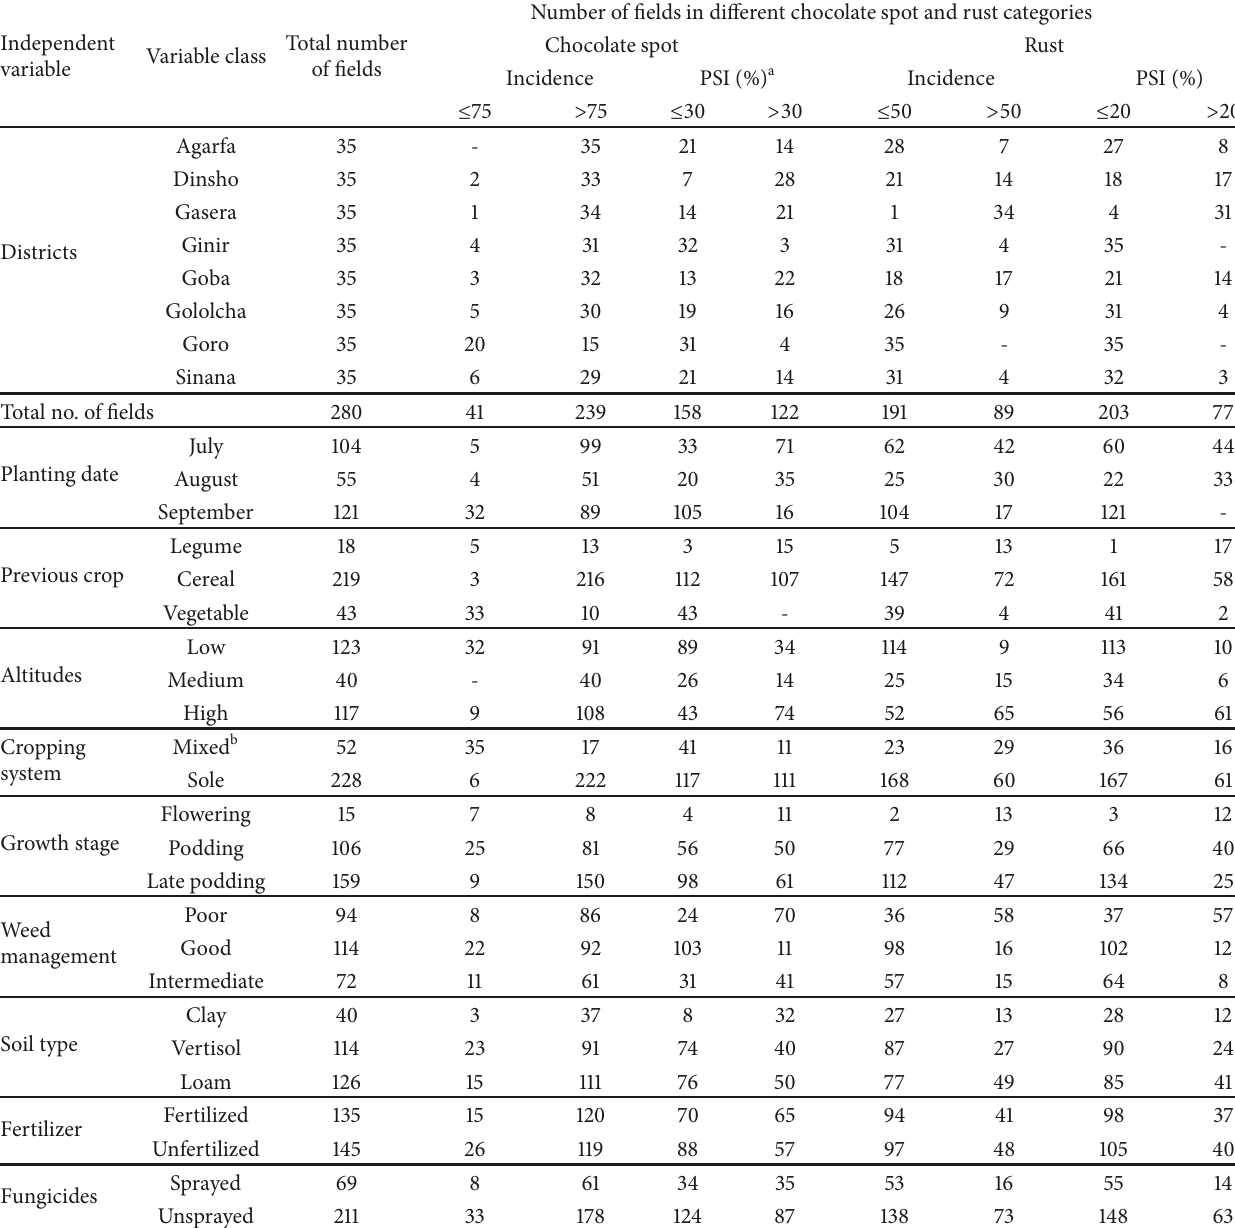
Table 2: Independent variable by disease contingency table for logistic regression analysis of chocolate spot and rust during 2017 main cropping season in eight districts (n=280) of Bale highlands, south eastern Ethiopia. Number of fields in different chocolate spot and rust categories Independent Total number Chocolate spot Rust Variable class variable of fields Incidence PSI ( % ) a